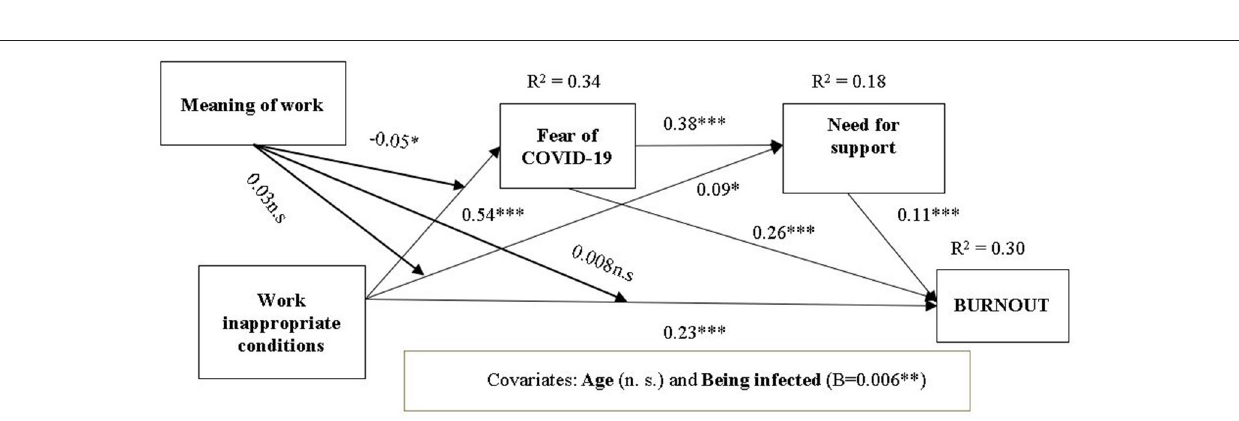
FIGURE 2 | Model—mediational model of relationship between Work inappropriate conditions and Burnout through Fear of COVID-19 consequences and Need for emotional support.